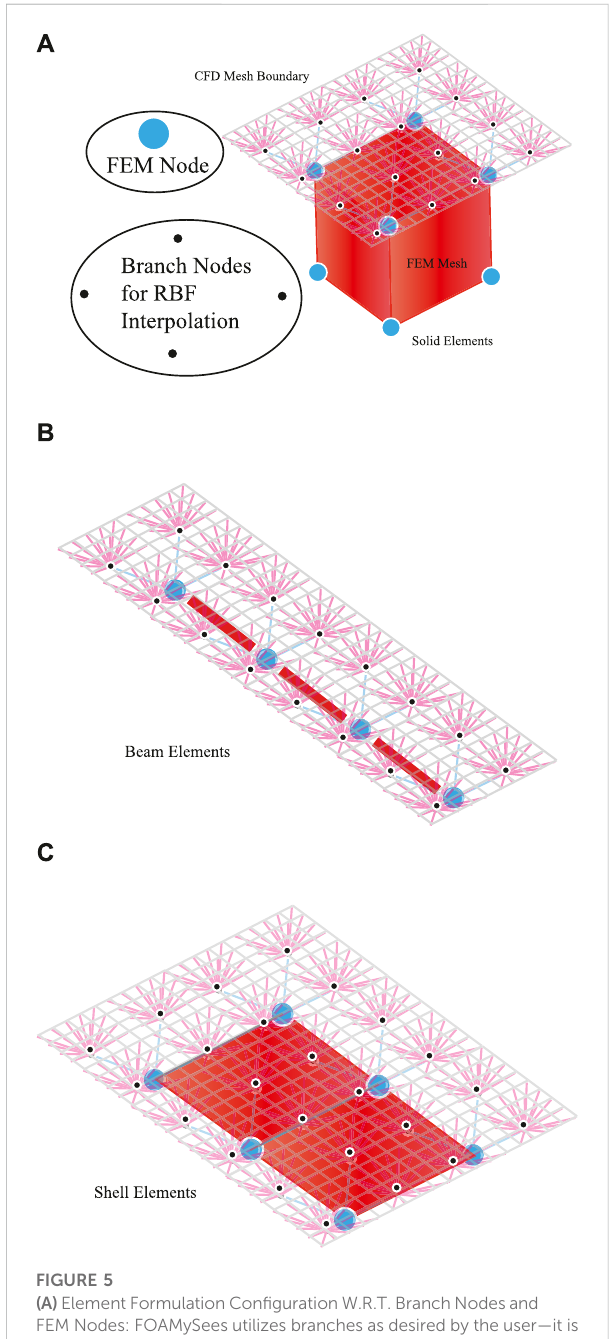
FIGURE 5 (A) ElementFormulation Con fi gurationW.R.T. BranchNodesand FEM Nodes: FOAMySees utilizes branches as desired by the user — it is necessary for beam elements, recommended for shell elements, and unnecessary and improper for solid elements, as solid element meshes shouldbebody- fi tted:Solidelements, (B) Beam elements, (C) Shell